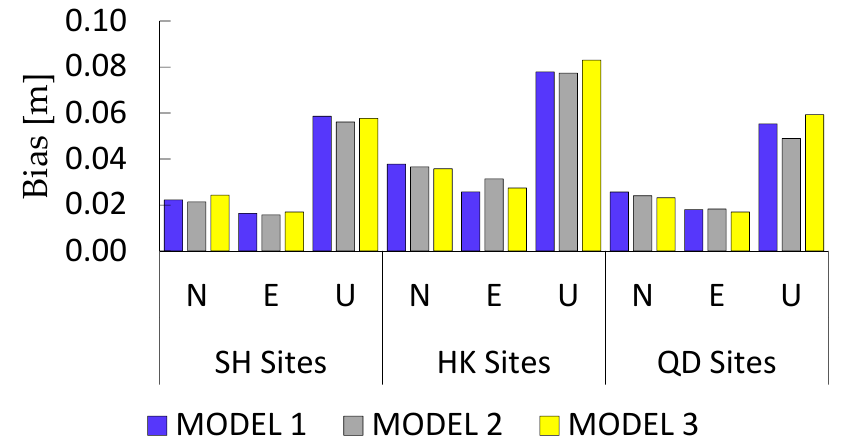
Figure 11. RTPPP-AR positioning accuracies of different regional stations in different models.